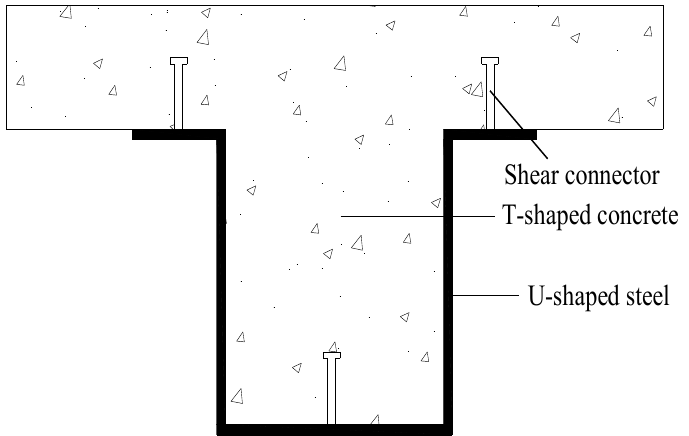
Figure 1. Concrete-filled U-shaped steel (CFUS) beam.